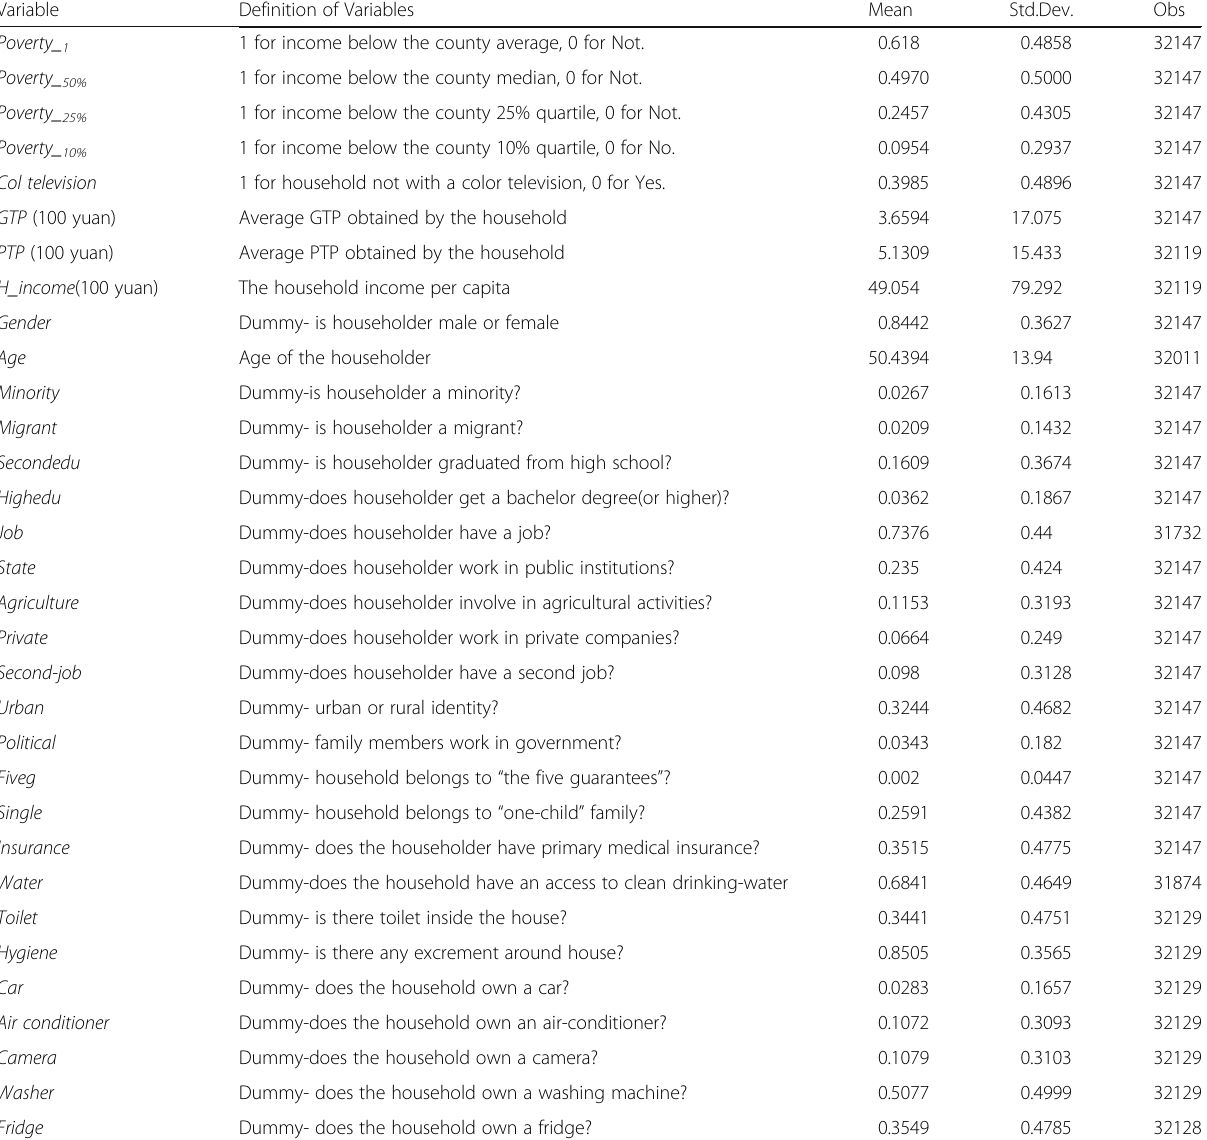
Table 2 The Definitions and Summary